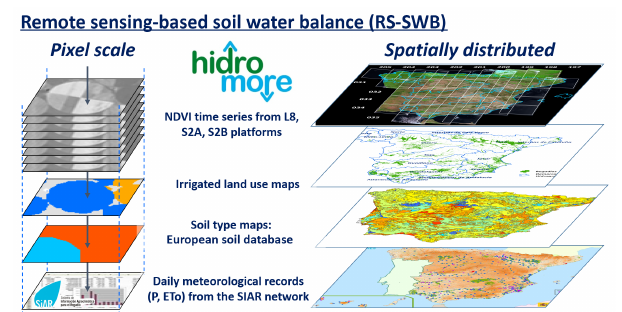
Figure 2. Inputs databases used in HidroMORE ® to calculate the RS-SWB at pixel scale and spatially